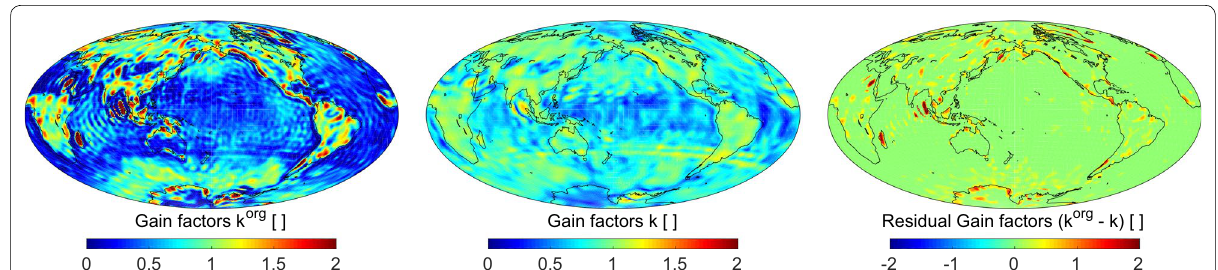
Fig. 3 Comparison of the global grid point gain factors derived from simulated true and once filtered equivalent water heights ( k org ) and derived from simulated once and twice filtered equivalent water heights ( k ) as well as the differences